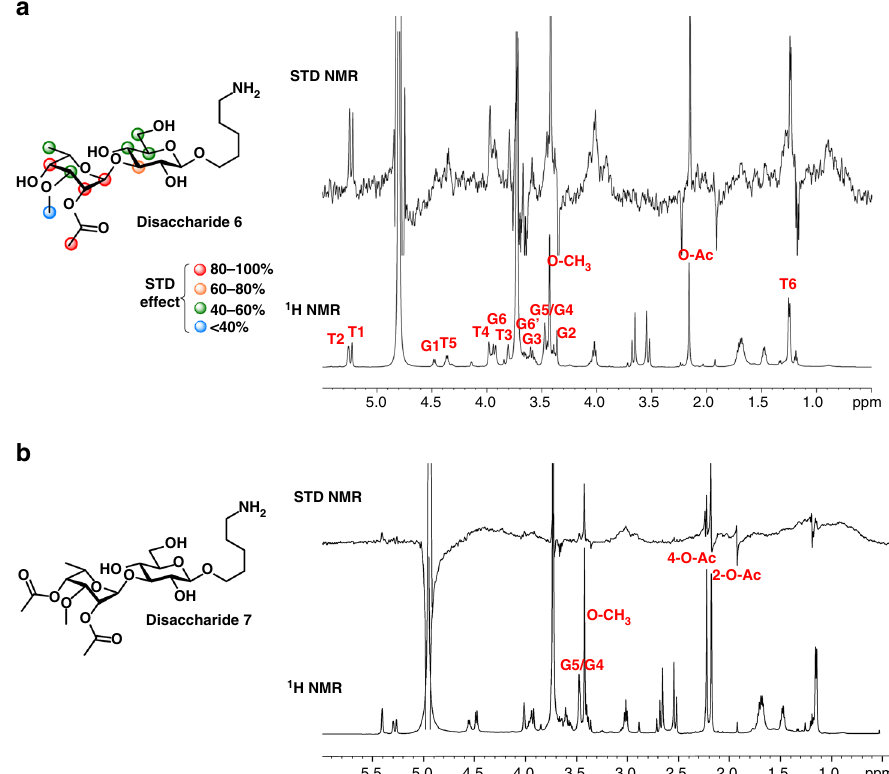
Fig. 7 Epitope mapping of disaccharides/mAb 4C7 interactions probed by STD-NMR. Chemical structures and epitope binding of disaccharides 6a and 7b to mAb 4C7 along with reference 1 H and STD NMR spectra at 298 and 283 K, respectively. Color code indicates the percentages of STD effects. Low and not quanti fi able STD effects were detected for disaccharide 7 . Both STD 1D NMR spectra were run with a 1:100 mAb 4C7/disaccharide mixture. The irradiation frequency was set at 8 ppm and a saturation time of 2 s was used. The proton resonances belonging to talose and glucose residues were indicated with letters , T and G ,